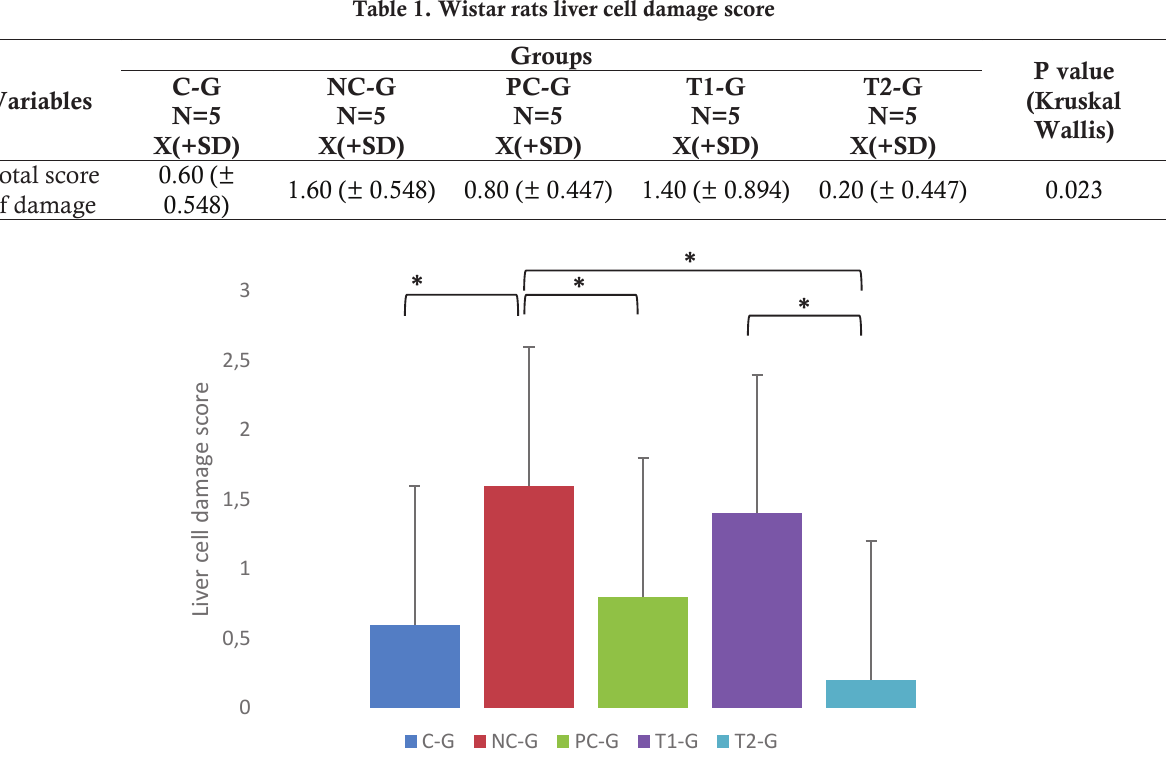
Table 1. Wistar rats liver cell damage score